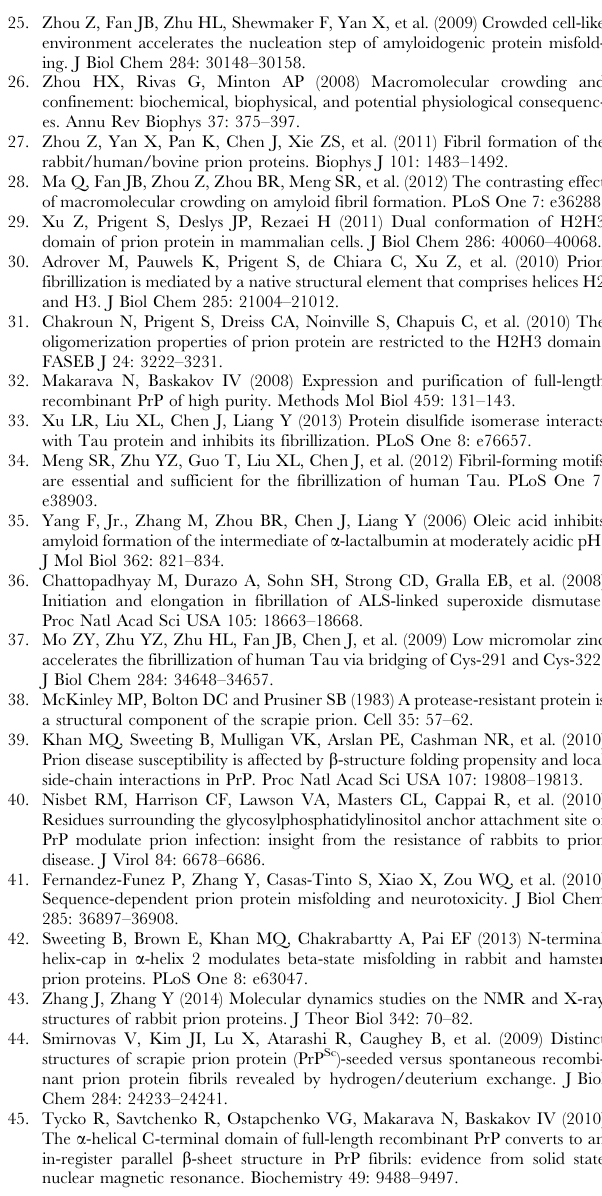
Table S4 The primers used to construct chimera R in which the rabbit PrP-B1H1B2 ( b -strand 1, a -helix 1, and b -strand 2) was replaced by the human